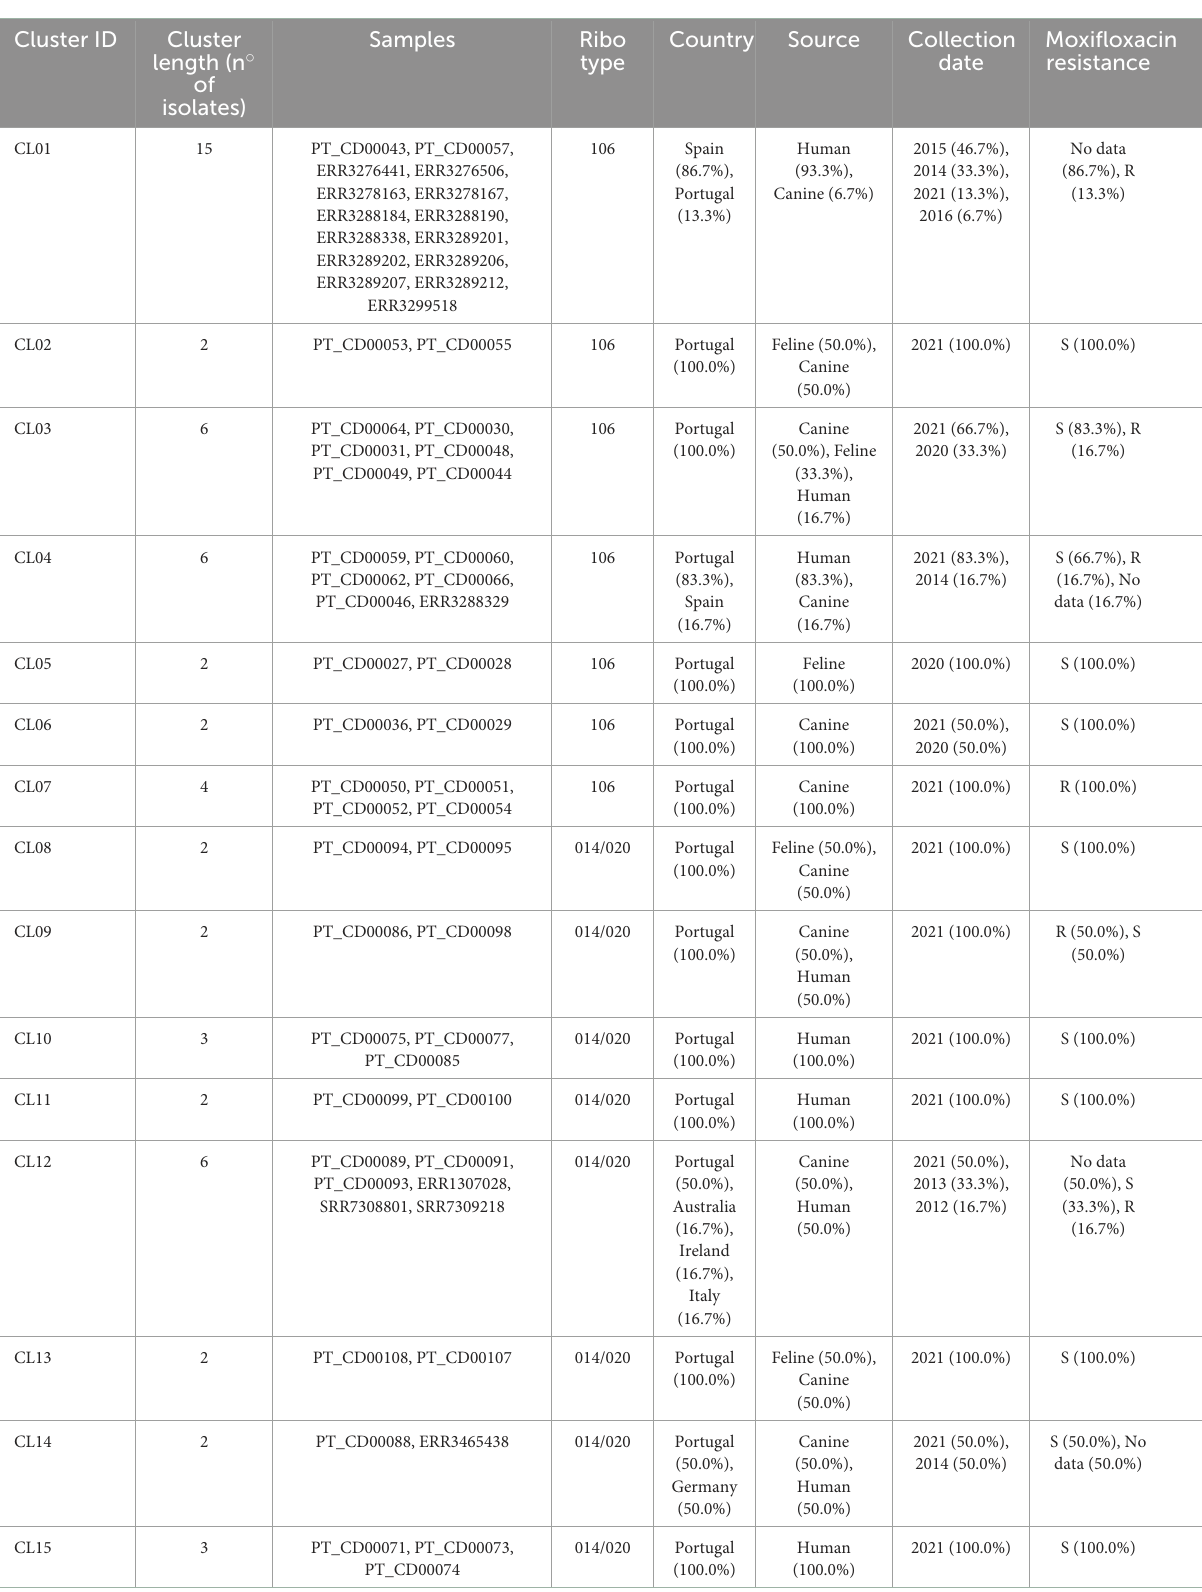
TABLE 3 Genetic clusters including Clostridioides difficile isolates from